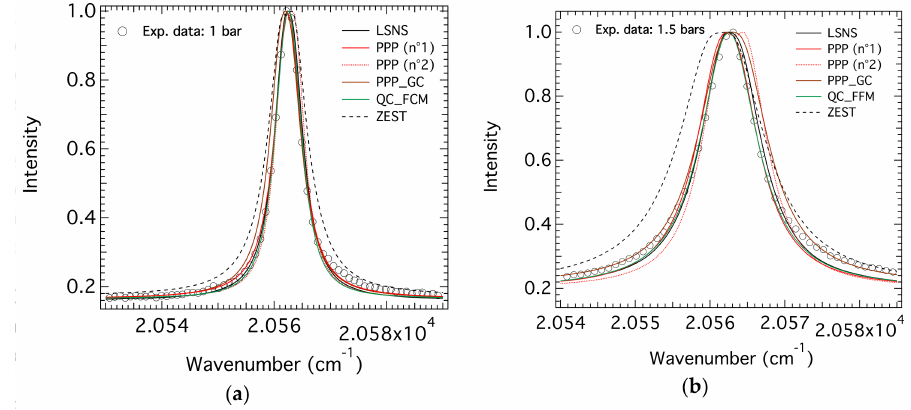
Figure 12. The comparison/fitting of the low-pressure H- β spectra taking into account the Stark effect. Other broadening mechanisms like Doppler and van der Waals were not necessarily taken into account by all the codes. ( a ) P = 1 bar; ( b ) P = 1.5